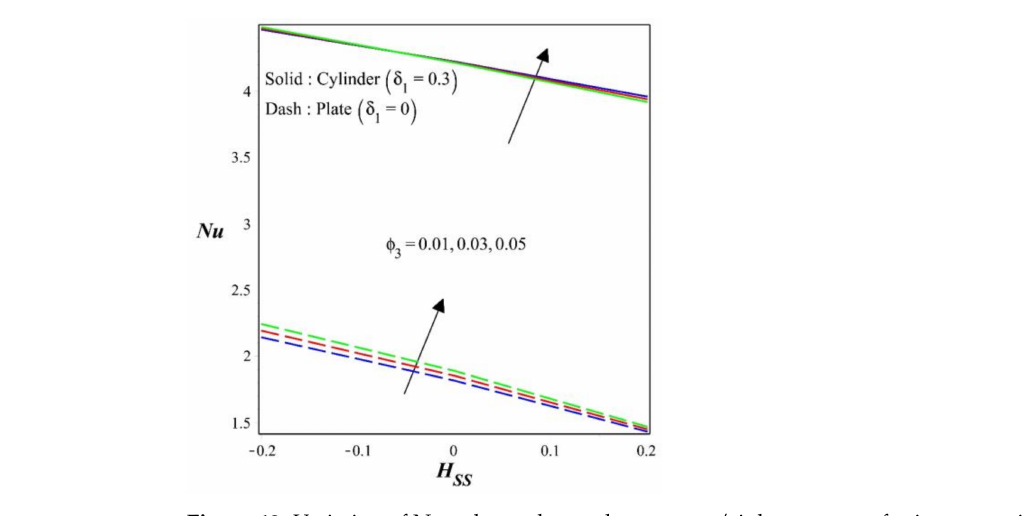
Figure 12. Variation of Nusselt number on heat source/sink parameter for increment in solid volume